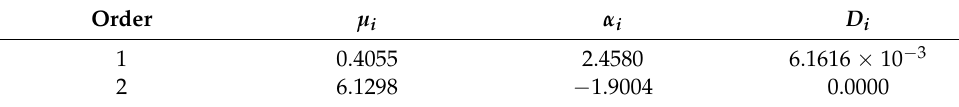
Figure 7. Experimental and Ogden model (N = 2) behaviour for the employed TPU. Table 3. Ogden material model parameters for the employed TPU.